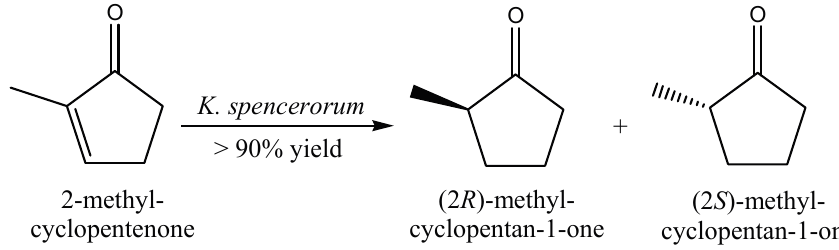
Figure 11. Bioconversion of 2-methyl-cyclopentenone by whole-cells of K. spencerorum